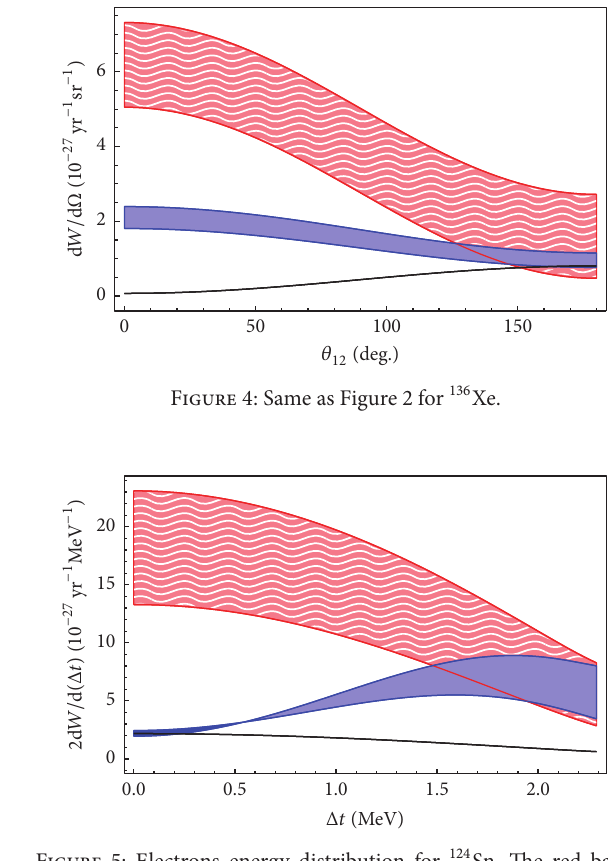
Figure 5: Electrons energy distribution for 124 Sn. The red band corresponds to 𝜂 mechanism and the blue band corresponds to 𝜆 mechanism. The width of the bands represents the uncertainties arising from the unknown CP phases 𝜙 1 and 𝜙 2 .